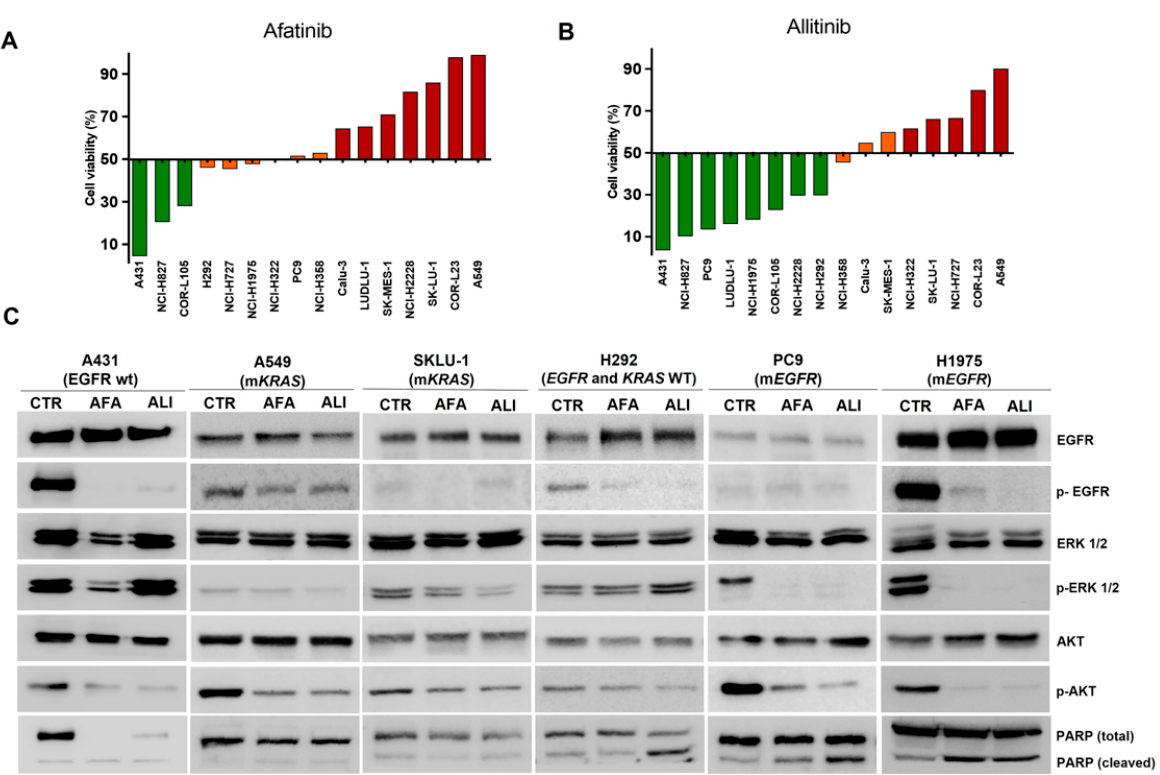
Figure 1. The comparative effect between afatinib and allitinib. The growth inhibition score (GI) of NSCLC cells was calculated for afatinib ( A ) and allitinib ( B ) at 1000 nM, classified as highly sensitive-HS (green bars), moderate sensitivity-MS (orange bars), and resistant-R (red bars). ( C ) Western blot analysis of EGFR, ERK, and AKT total or phosphorylated and cleaved PARP. EGF ligand was used at 10 ng/mL for 10 min. CTR: control; AFA: afatinib, ALI: allitinib at 0.2 µM.